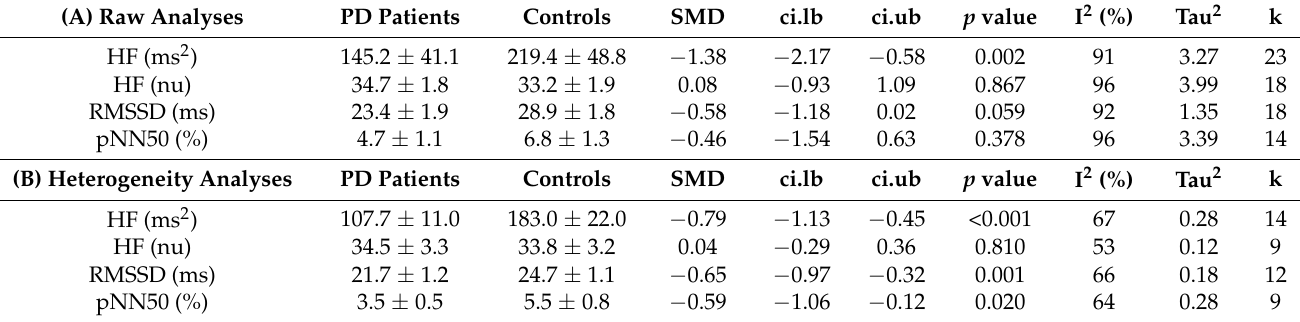
Values are given as mean or as mean ± SD, unless otherwise indicated: ( A ) raw analyses; ( B ) heterogeneity analyses; ci.lb: confidence interval lower bound; ci.ub: confidence interval upper bound; HF: high frequency components of the power spectral density; HRV: heart rate variability; k: number of considered studies; nu: normalized units; PD: Parkinson’s disease; pNN50: number of normal-to-normal intervals differing by more than 50 ms divided by the total number of normal-to-normal intervals; RMSSD: Root mean square of successive normal-to-normal interval differences; SMD: standardized mean